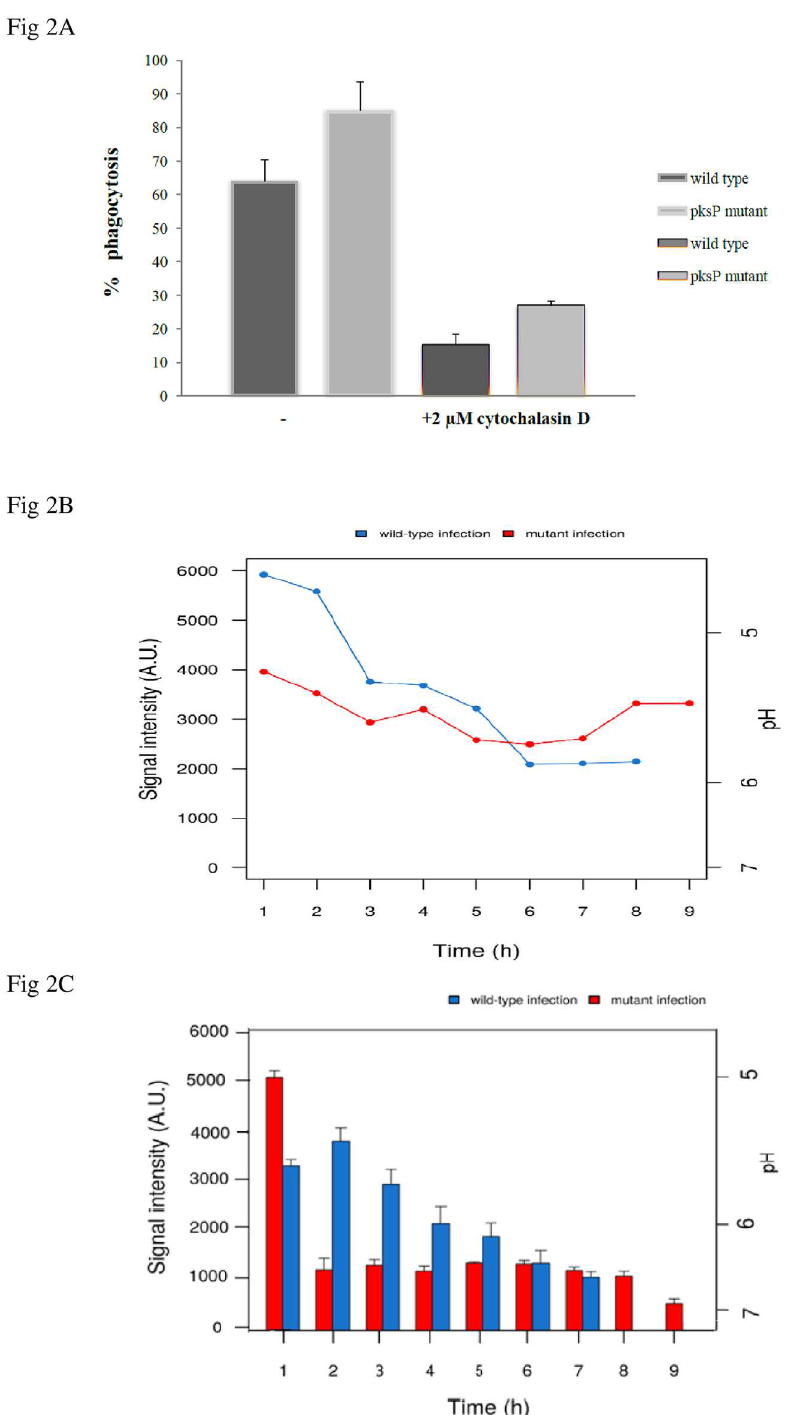
Fig 2. (A) The effect of cytochalasin D treatment on phagocytosis of A.fumigatus conidia (wild-type and mutant) . The cells that have been pretreated with 2 μ M cytochalasin D, showed a limited tendency towards phagocytosis the conidia in compared to the untreated cells. The 1 h treatment of MM6 monocytes with cytochalasin D reducedthe rate of engulfed conidiato ~ 19% in wild type and 30% in mutant. (B) pH variation in monocyte after infection with wild-type conidia (blue line) and the monocyte infected with pksP mutant conidia (red line) . Intracellular pH was calculated via linear regressionanalysisbased on fluorescence spectra ratio in comparison to the generated pH standard curve. In general, pH